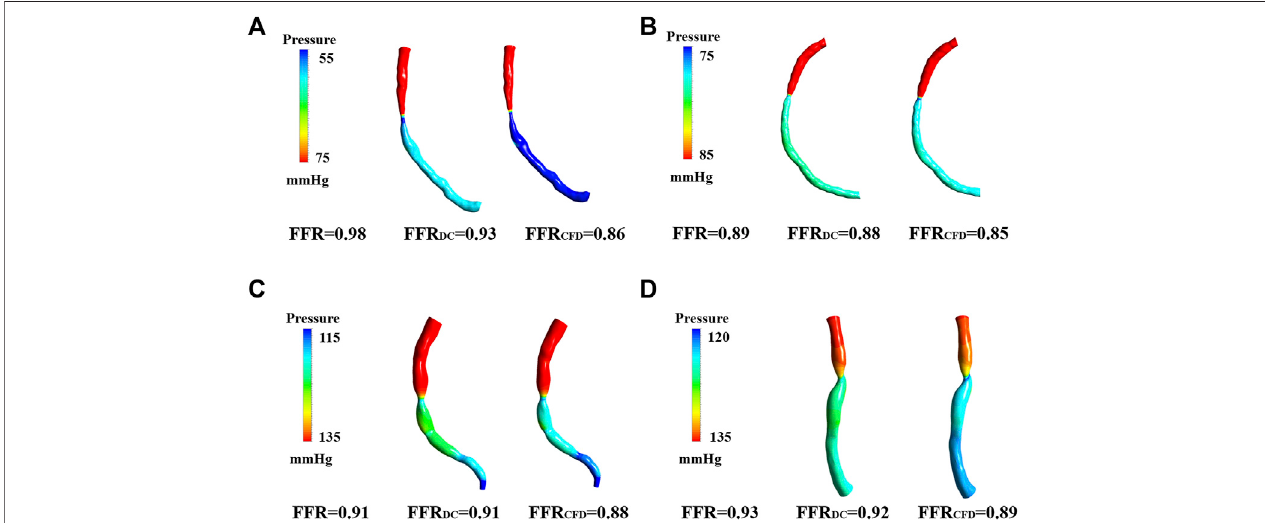
FIGURE 5 | FFRct Pressure cloud image calculated based on dual models. (A) Pressure cloud of patient 2 for both computational models. (B) Pressure cloud of patient 4 for both computational models. (C) Pressure cloud of patient 6 for both computational models. (D) Pressure cloud of patient 5 for both computational models.